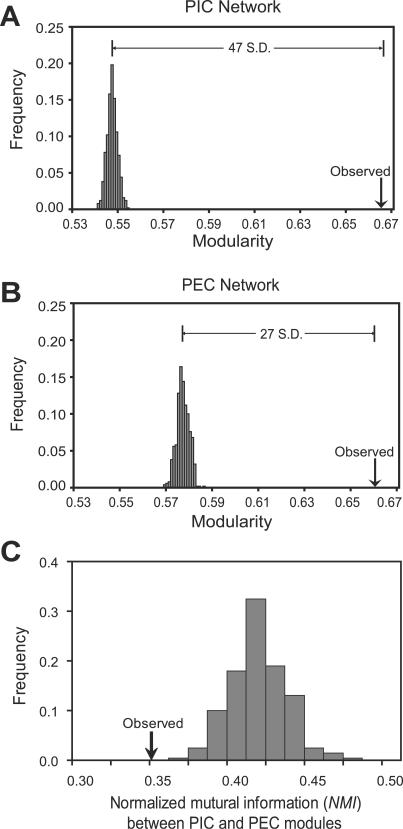
The Modularity of Yeast PIC and PEC Networks Compared with That of Their Randomly Rewired Networks, and the Similarity of Module Compositions between PIC and PEC Networks Compared with the Random Expectation(A,B) The observed modularity is indicated by the vertical arrow. The bars show the frequency distribution of the modularity from 500 randomly rewired networks. Scaled modularity, or the difference between the modularity of a real network and the expected modularity of a randomly rewired network in terms of the number of standard deviations, is indicated at the top area of the panel.(C) The observed similarity between PIC and PEC networks, measured by NMI, is indicated by the vertical arrow. The bars show the frequency distribution of the NMI between PIC and 200 reduced networks (by random removal of 10% edges from the PIC network). The result shows that the difference between PEC and PIC is not simply because the PEC network is 10% smaller than the PIC network.